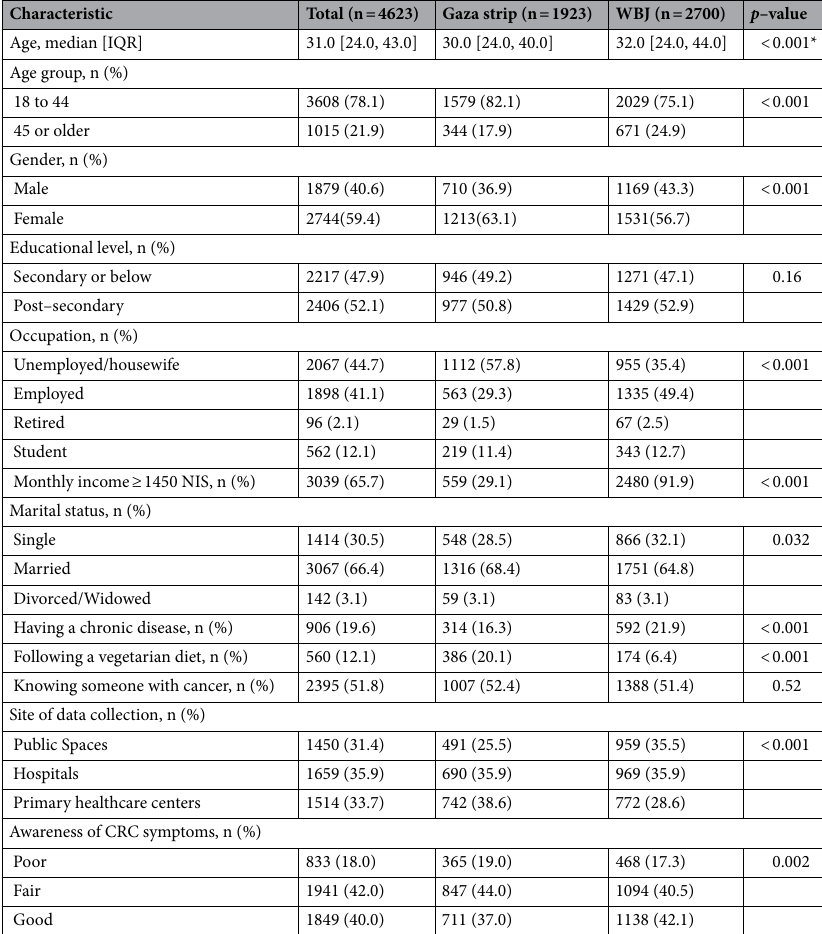
Table 1. Characteristics of study participants. n = number of participants, IQR = interquartile range, WBJ = West Bank and Jerusalem. All p -values are for Pearson’s Chi-square